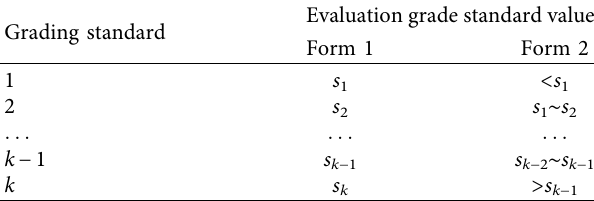
Table 1: Classification table of evaluation